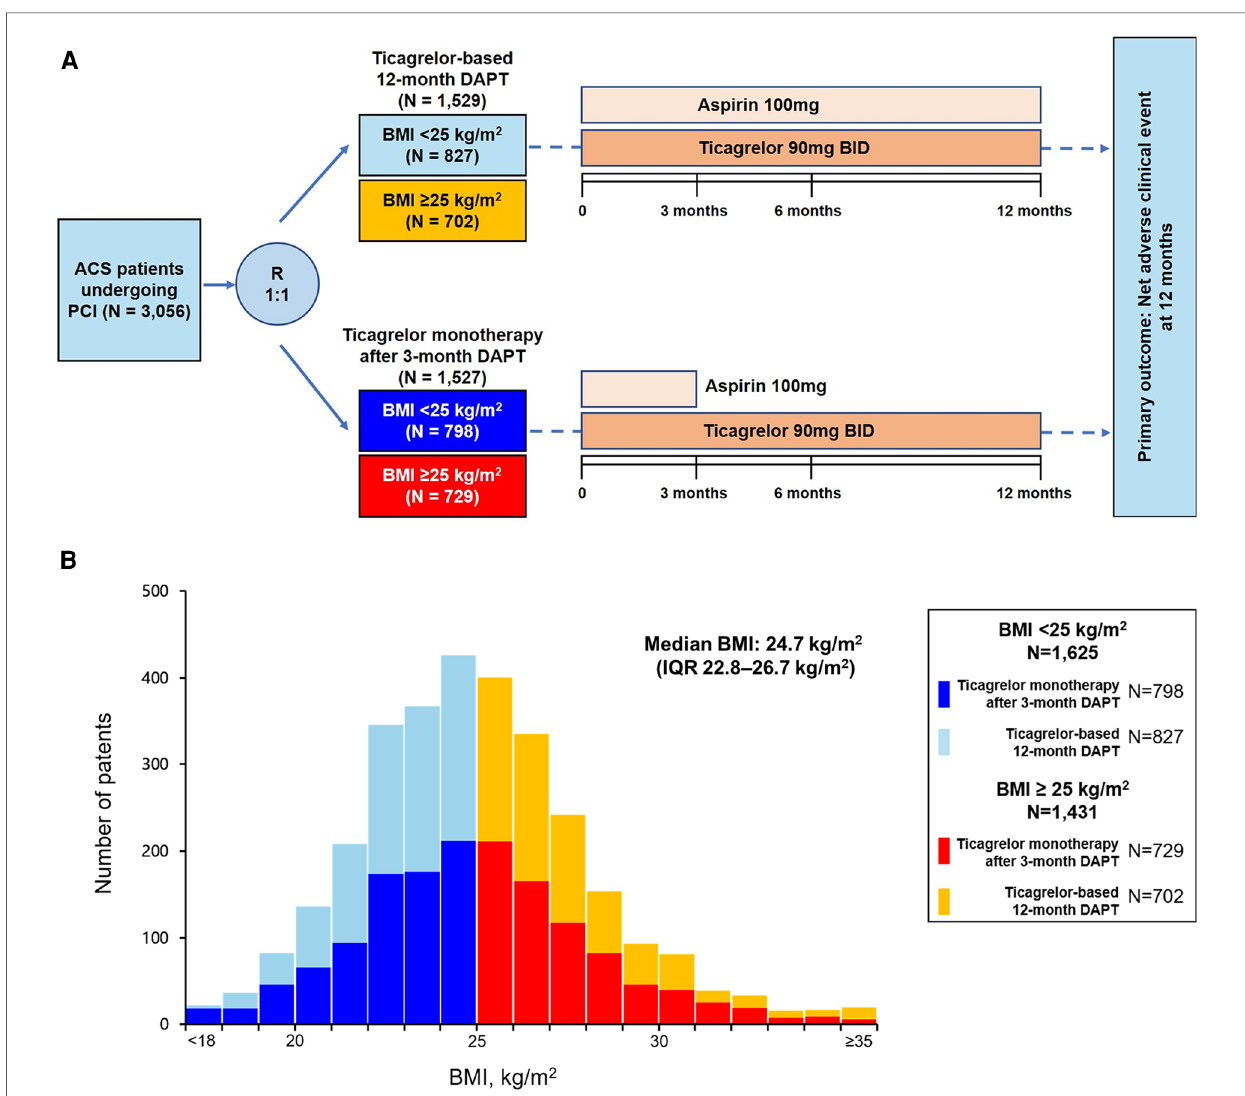
FIGURE 1 Flowchart of the present study and distribution of BMI. ( A ) Study fl ow, ( B ) distribution of BMI strati fi ed by antiplatelet therapy strategies. ACS, acute coronary syndrome; BMI, body mass index; DAPT, dual antiplatelet therapy; IQR, interquartile range; PCI, percutaneous coronary